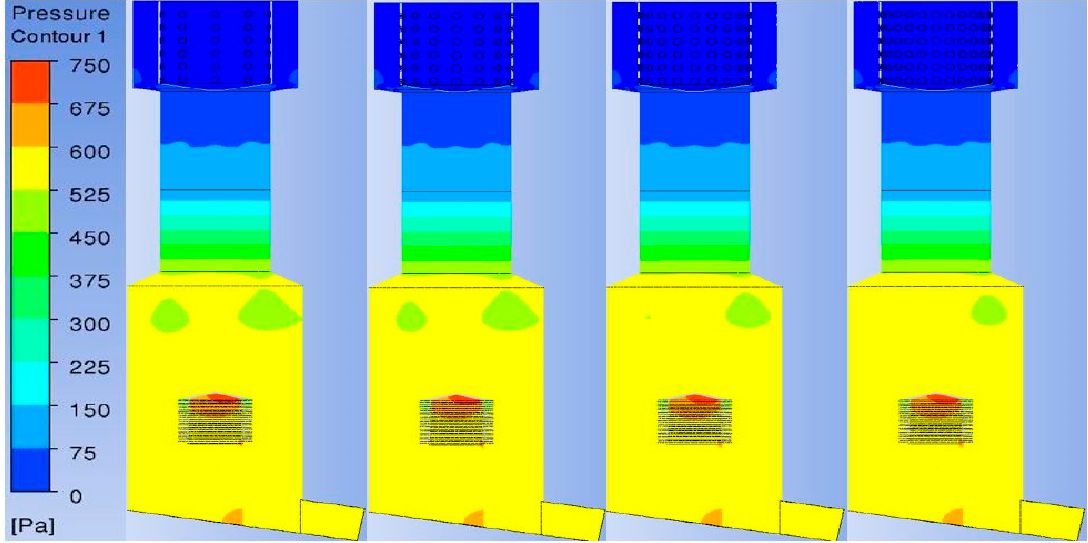
Figure 26. Pressure contour according to the number of holes in the inner resonate type.